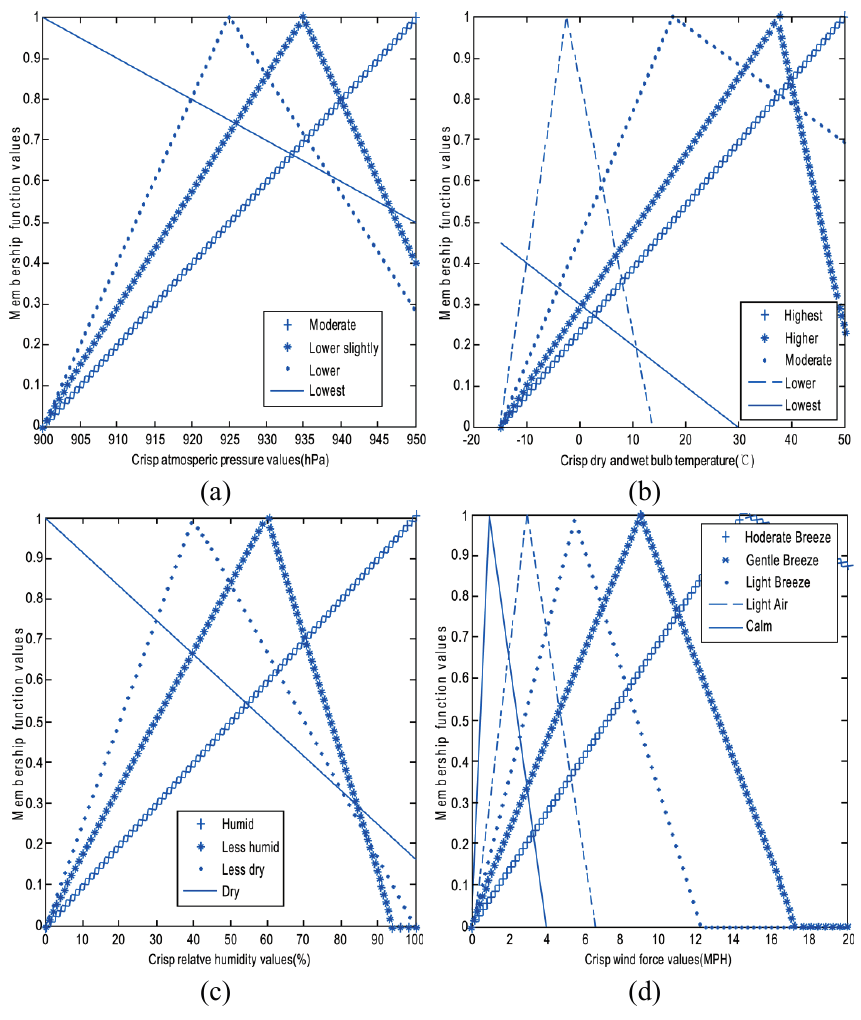
Figure 3. Membership function curves of meteorological fuzzy variable